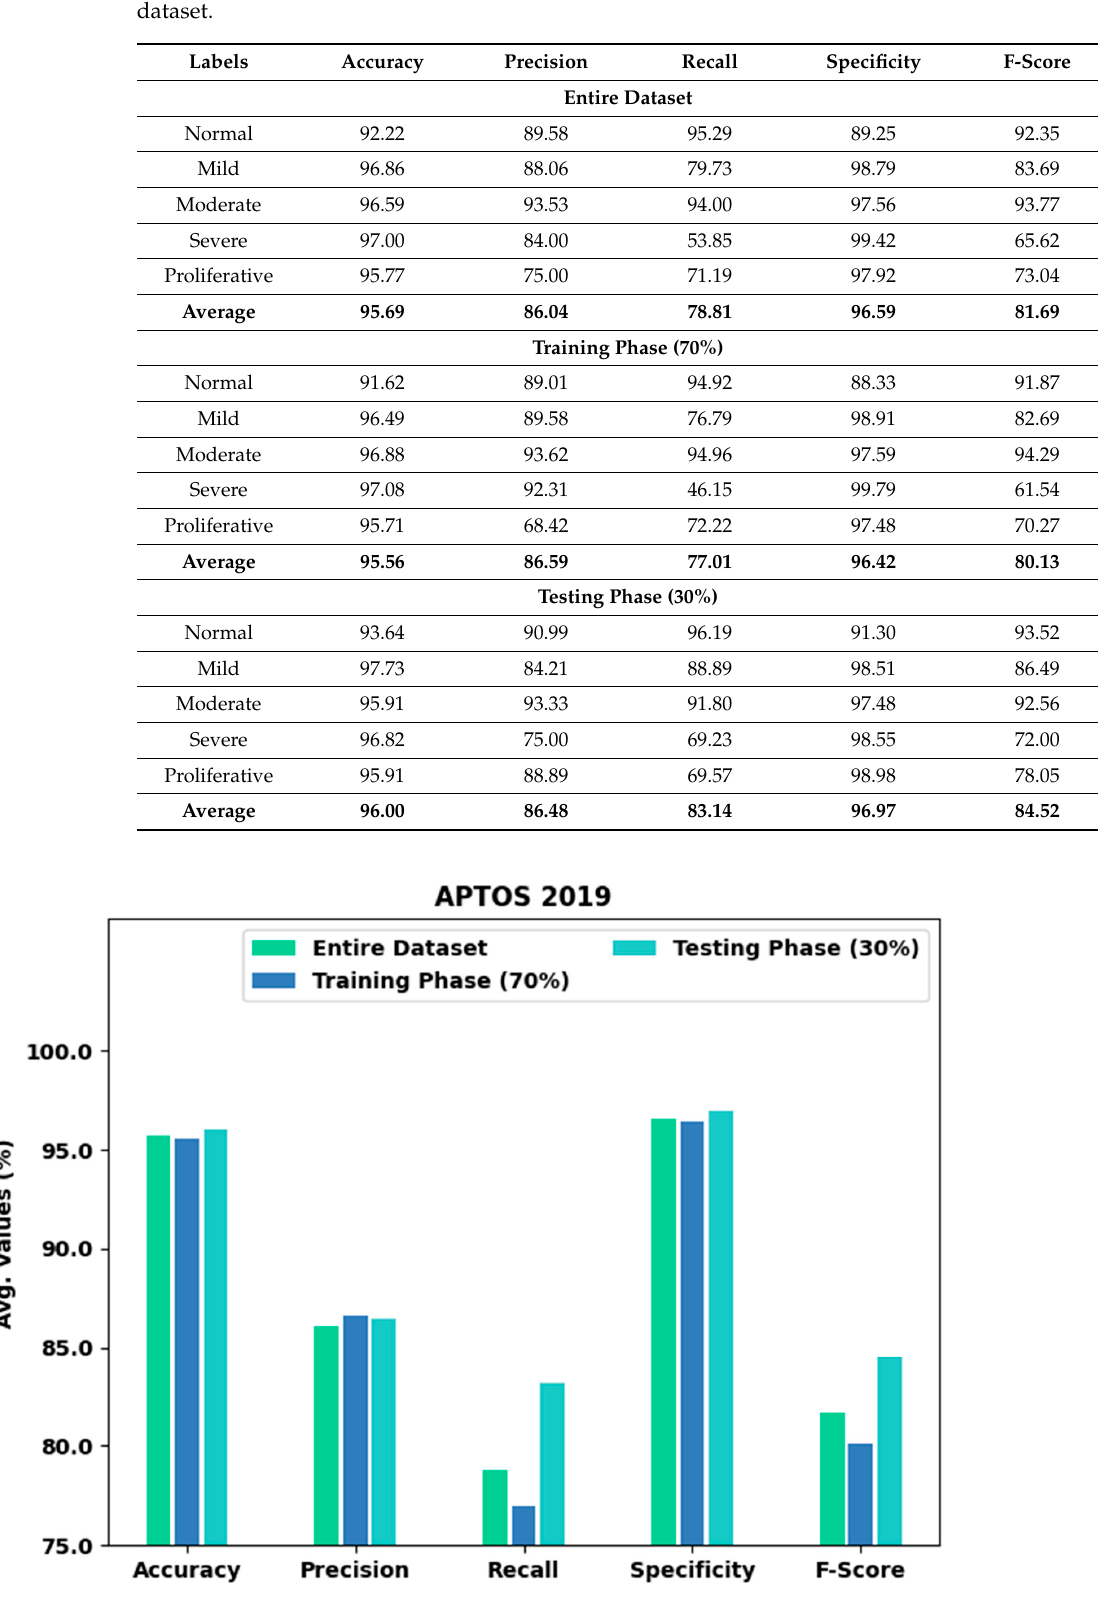
Figure 4. Result analysis of the XAITO-DRGC approach under the APTOS 2019 dataset.